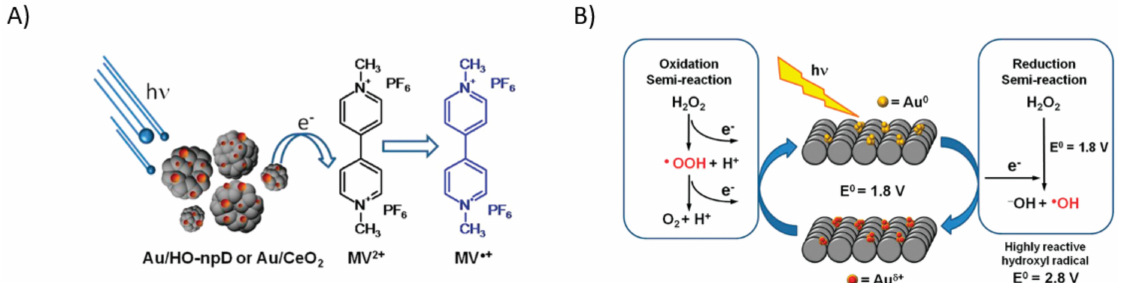
Figure 6. ( A ) Charge transfer of the hot-electrons to a probe molecule (MV 2+ ). Adapted with permission from Navalon et al. J. Am. Chem. Soc. 2011, 133, 7, 2218–2226. Copyright 2011, American Chemical Society [82]. ( B ) Hot-electrons applied to make the Fenton reaction for the AOP in the phenol degradation, and it’s the closing cycle reducing the oxidized gold to gold 0. Adapted with permission from Navalon et al. J. Am. Chem. Soc. 2011, 133, 7, 2218–2226. Copyright 2011, American Chemical Society [82].